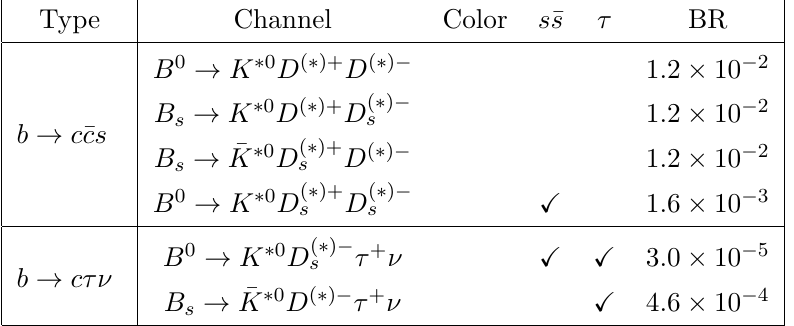
Table 5 . Major backgrounds for the B 0 → K ∗ 0 τ + τ − measurement. “Color”, “ s ¯ s ” and “ τ ” represent the three effects suppressing the B -meson decays which are discussed in the